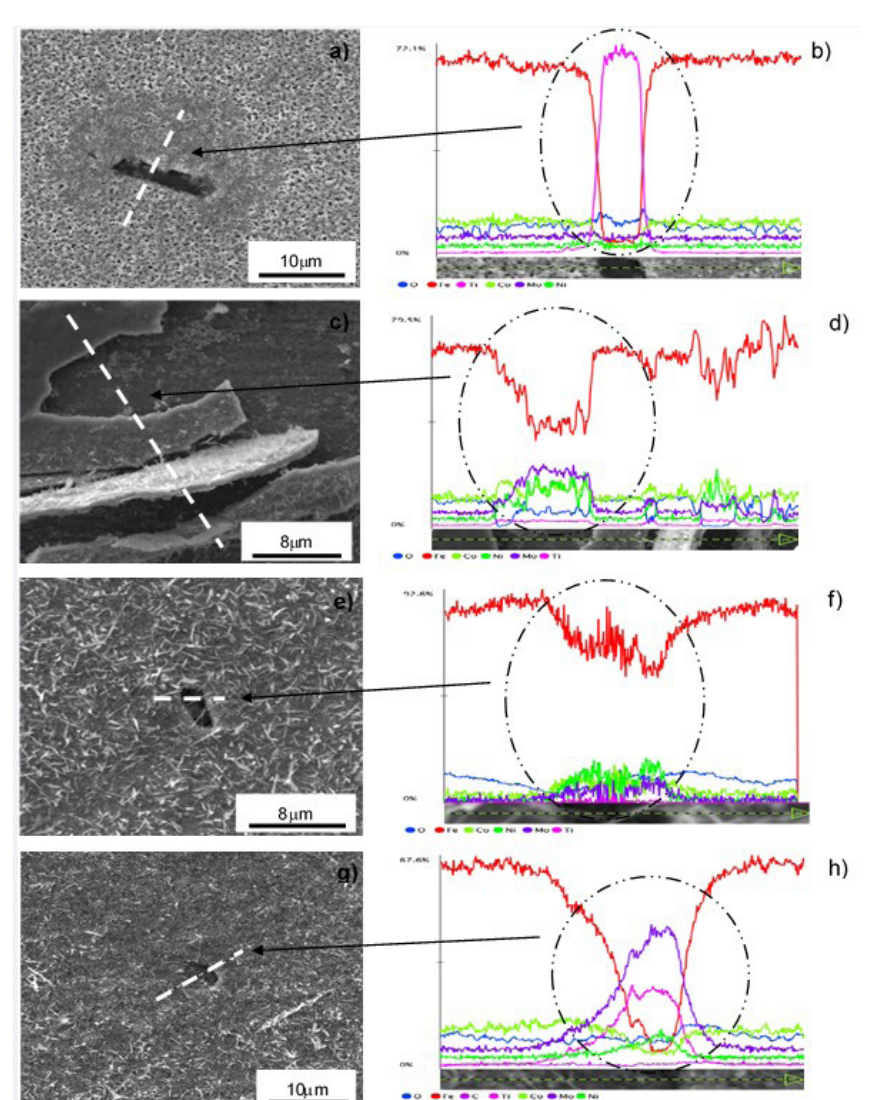
atmosphere, (c,d) air atmosphere, and 2